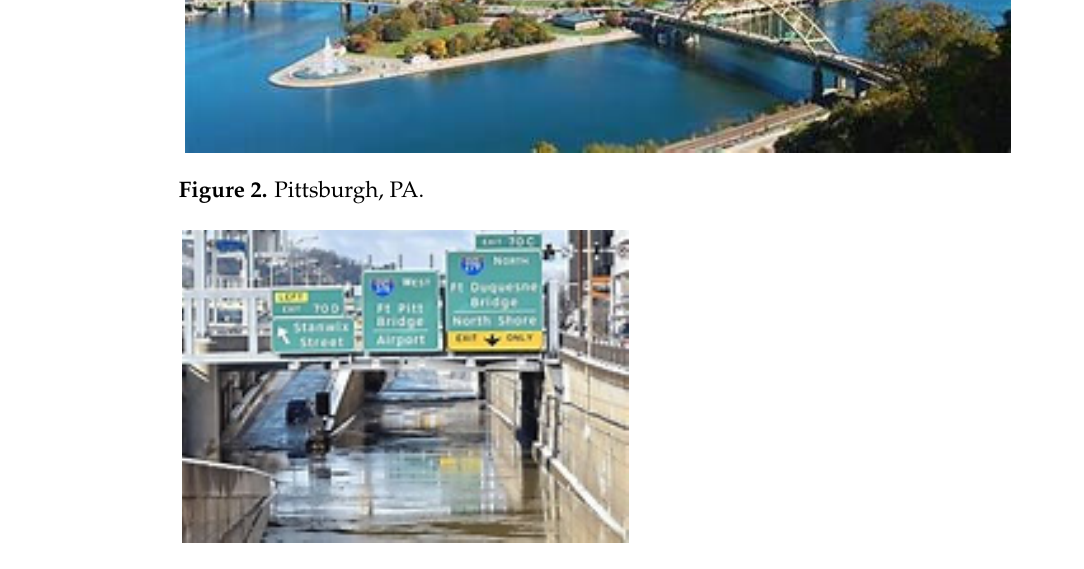
Figure 3. Pittsburgh, PA, flooding in 2021.